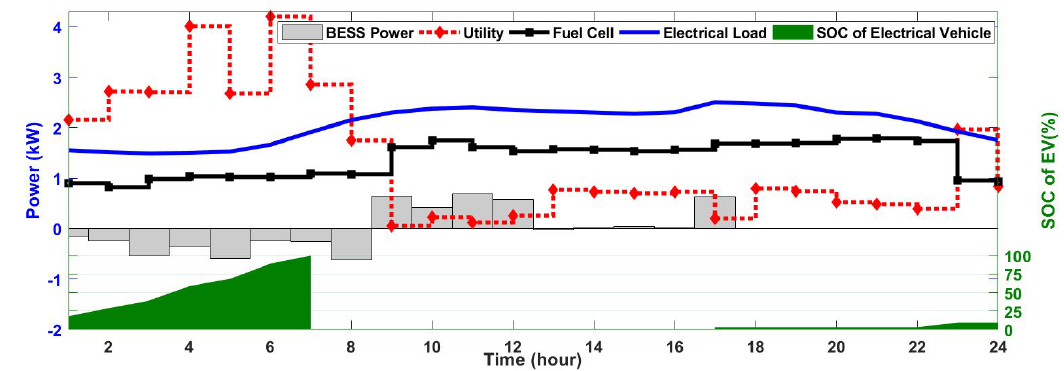
Figure 11. Case 6: Results of the simulation after adding battery energy storage